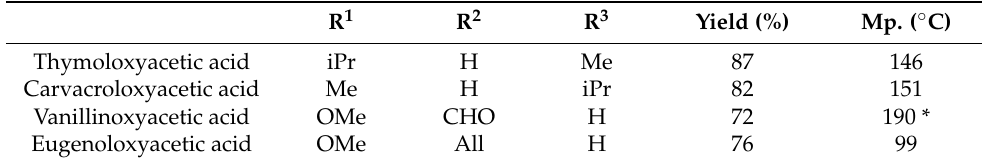
Table 8. Details of phenoxy acid